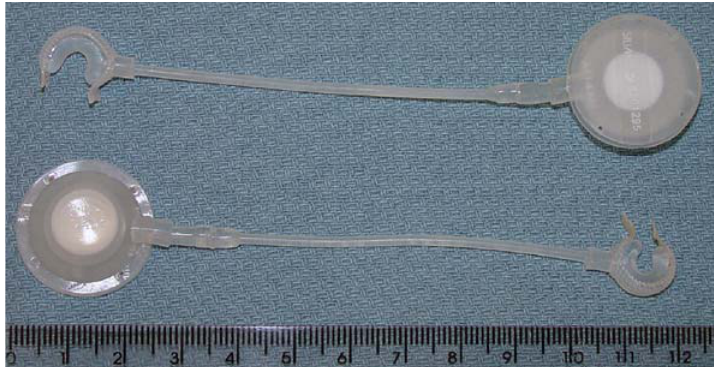
Fig. 1 - O dispositivo de bandagem ajustável da artéria pulmonar é feito com silicone de grau biomédico e consiste de três partes: manguito hidráulico, botão